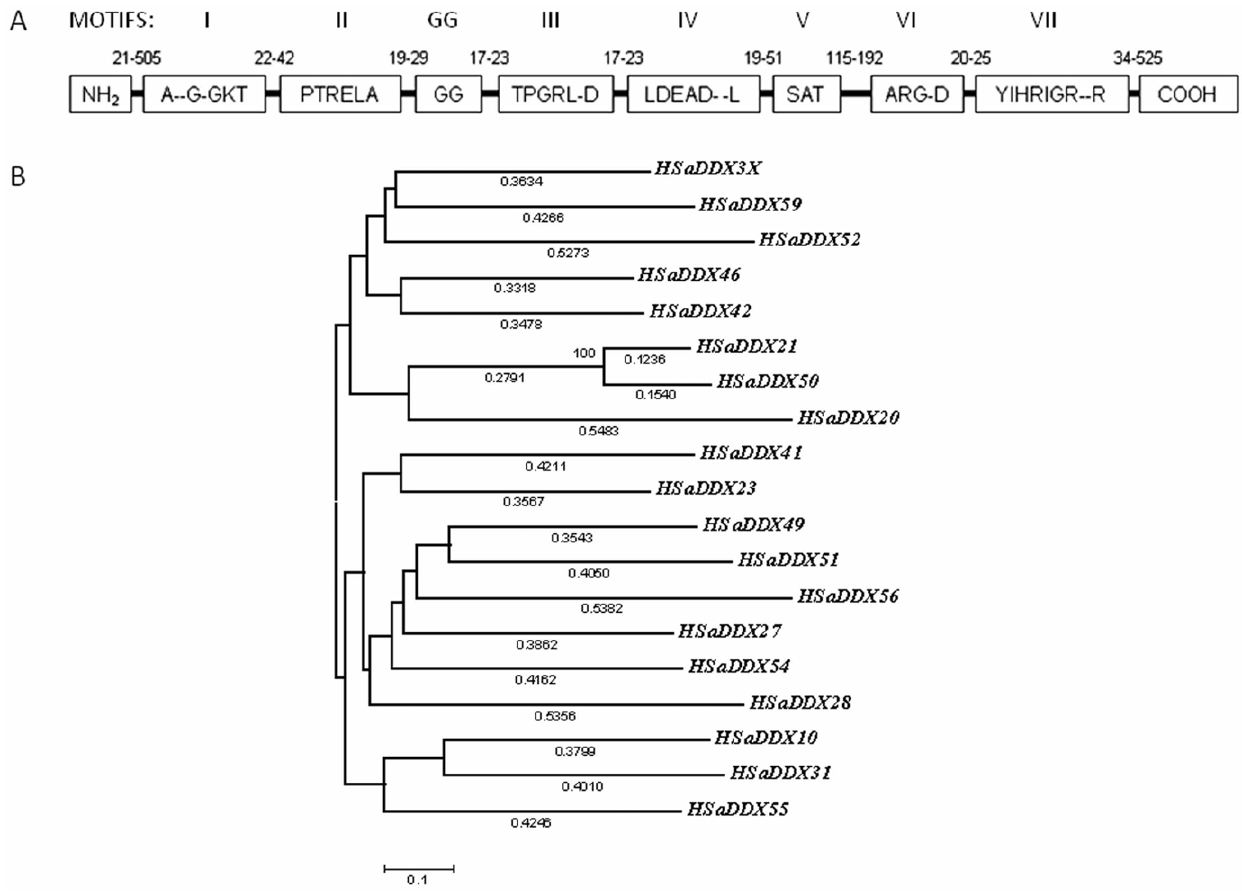
Figure 1. Shortlisted DEAD box helicases after alignment based iterations. A) Conserved DEAD box motifs common to all DEAD box helicases including DDX3X with inter-motif distances. B) Neighbour joining tree for selected DEAD box members. The tree had sum of branch lengths=8.2995. Cut off for bootstrap test (1000 replicates)= . 50%. Branch lengths were shown at the bottom of each branch.